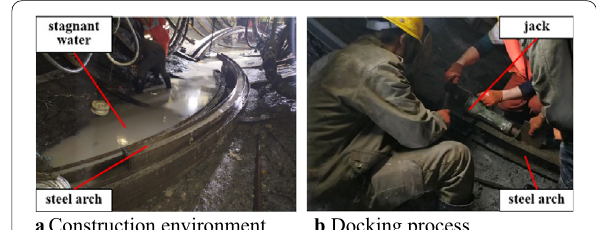
b Docking process